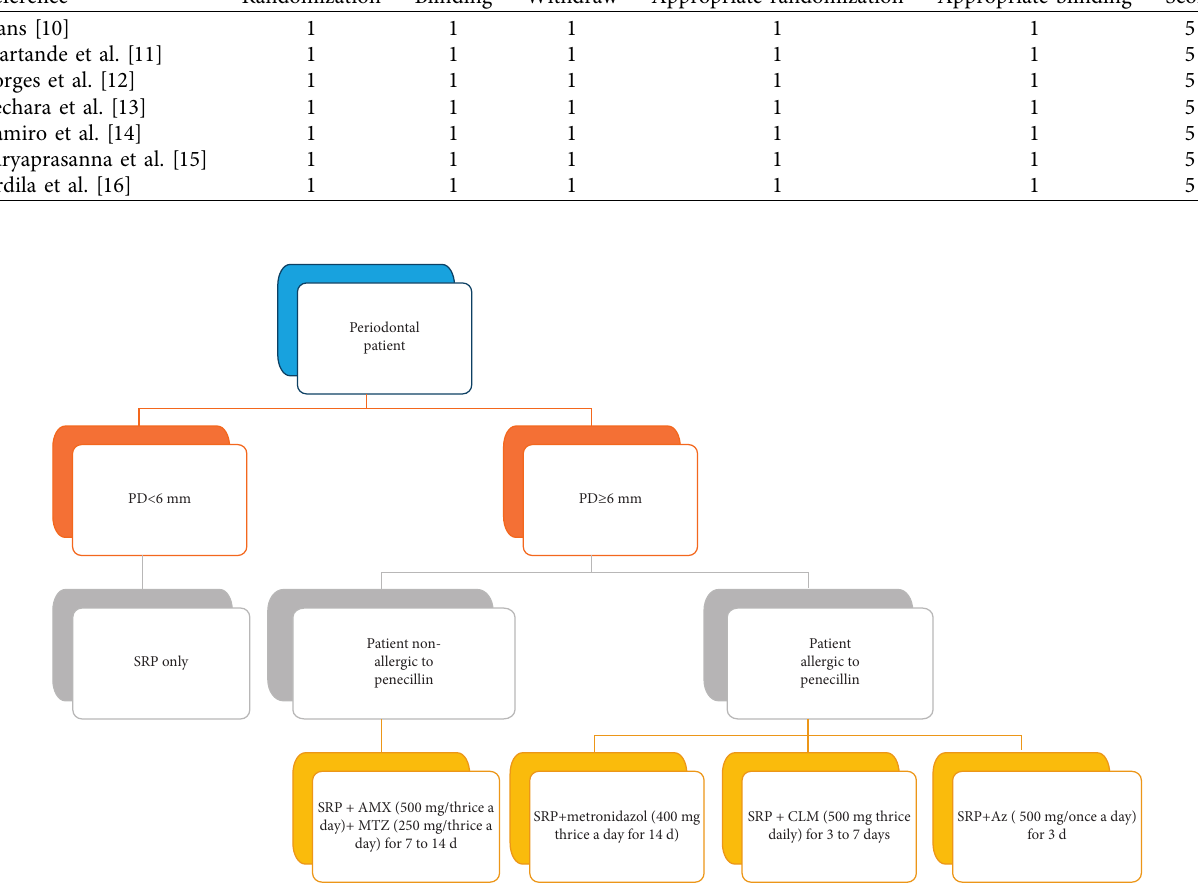
Figure 2: Summary of different effective suggested